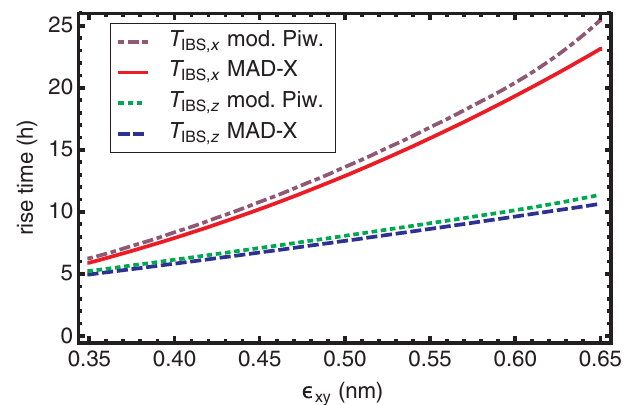
FIG. 14. (Color) Horizontal and longitudinal IBS rise times for the LHC collision scheme as a function of the transverse emittance as calculated with MAD-X and the modified Piwinski model (mod. Piw.). All other parameters were assumed constant with numerical values shown in Table The emittance shows the largest deviations (around 1% after 10 h), which is small compared to the overall error. shown for both models in Fig. 14.